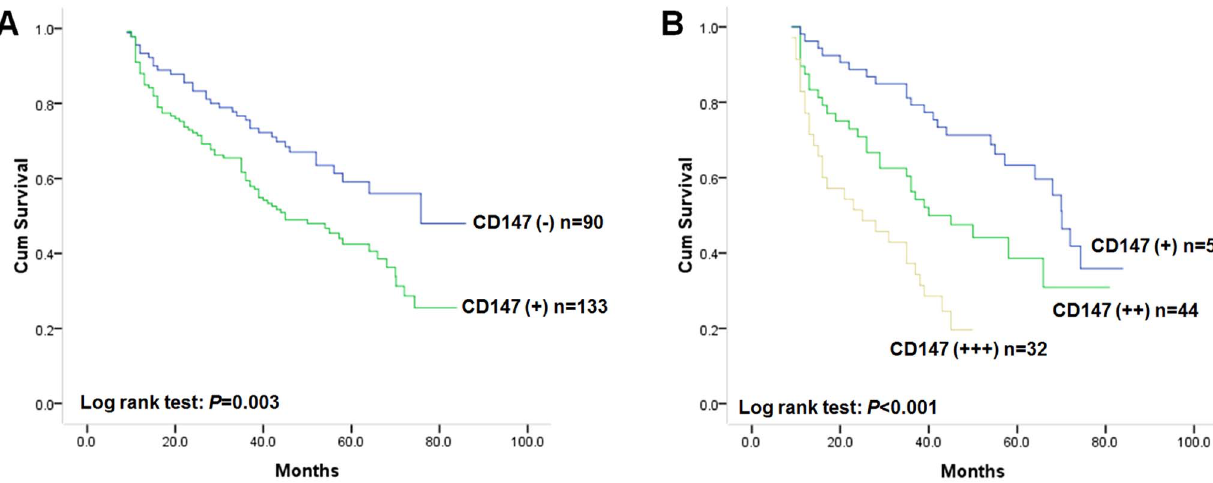
Figure 3. A Kaplan-Meier postoperative survival analysis on overall survival of primary gastric patients (n=223) with positive CD147 staining (n=133) and negative CD147 staining (n=90). The overall survival for patients in negative CD147 staining group was significantly better than that for patients in positive staining group (log rank test: P =0.003); B Kaplan-Meier postoperative survival analysis on overall survival of primary gastric patients with positive CD147 staining (n=133). The overall survival rate was decreased from weak positive ( + , n=57), moderate positive ( ++ , n=44) to strong positive ( +++ , n=32) CD147 staining group (log-rank test: P , 0.001).